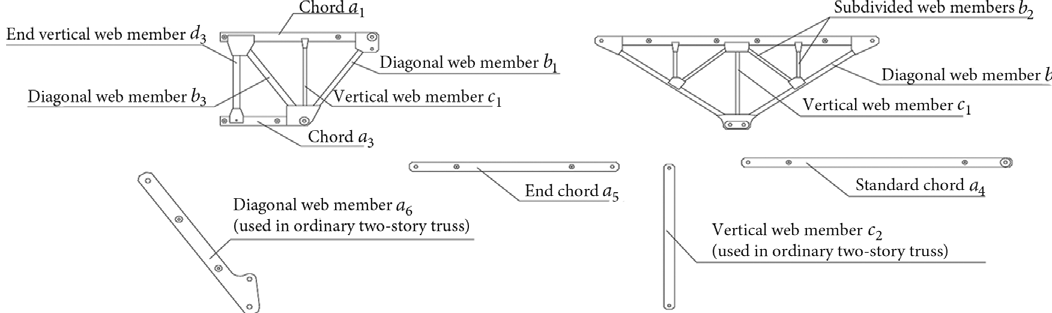
Fig. 2. Components of the assembly truss